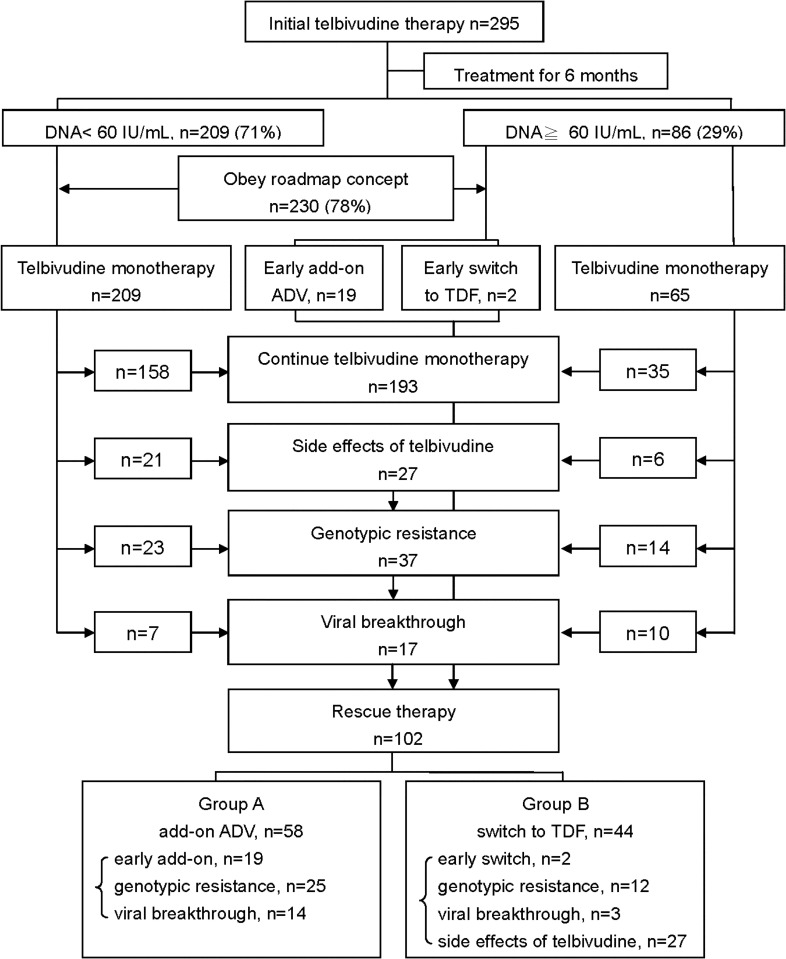
The flow chart of patients who initially received telbivudine therapy and then received a rescue therapy according to the roadmap rule.